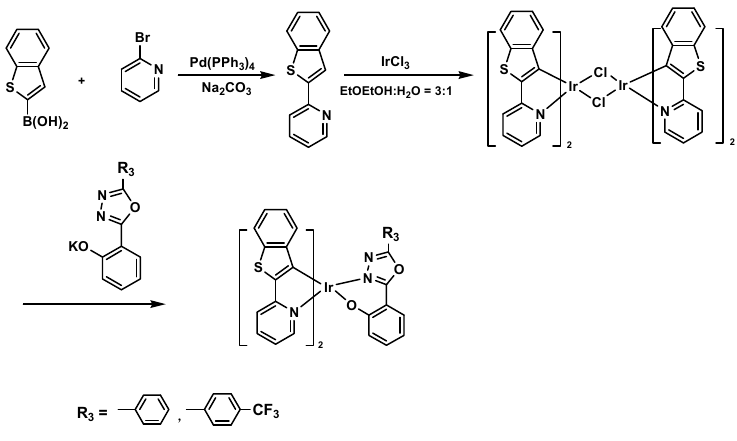
Figure 2. Synthesis route of Ir (III) coordination compound.